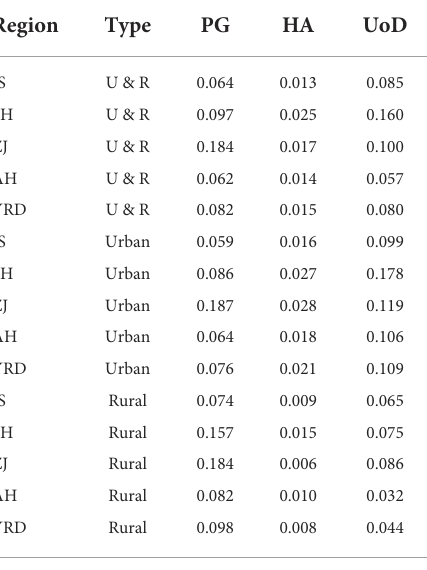
TABLE 6 Coefficient of variation for indicators of aids